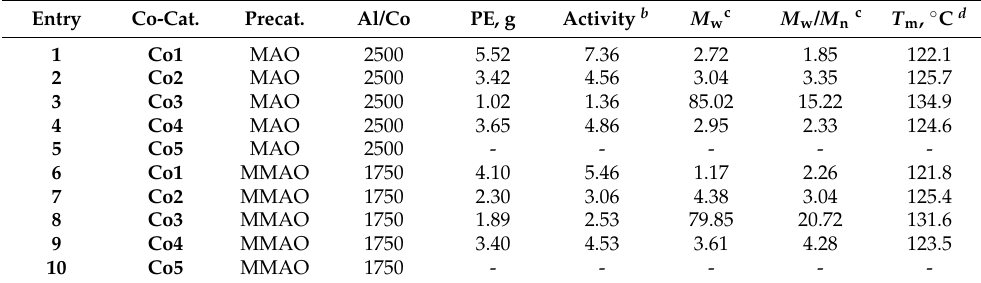
Table 4. Ethylene Polymerization using Co1 – Co5 with either MAO or MMAO as co-catalyst a .